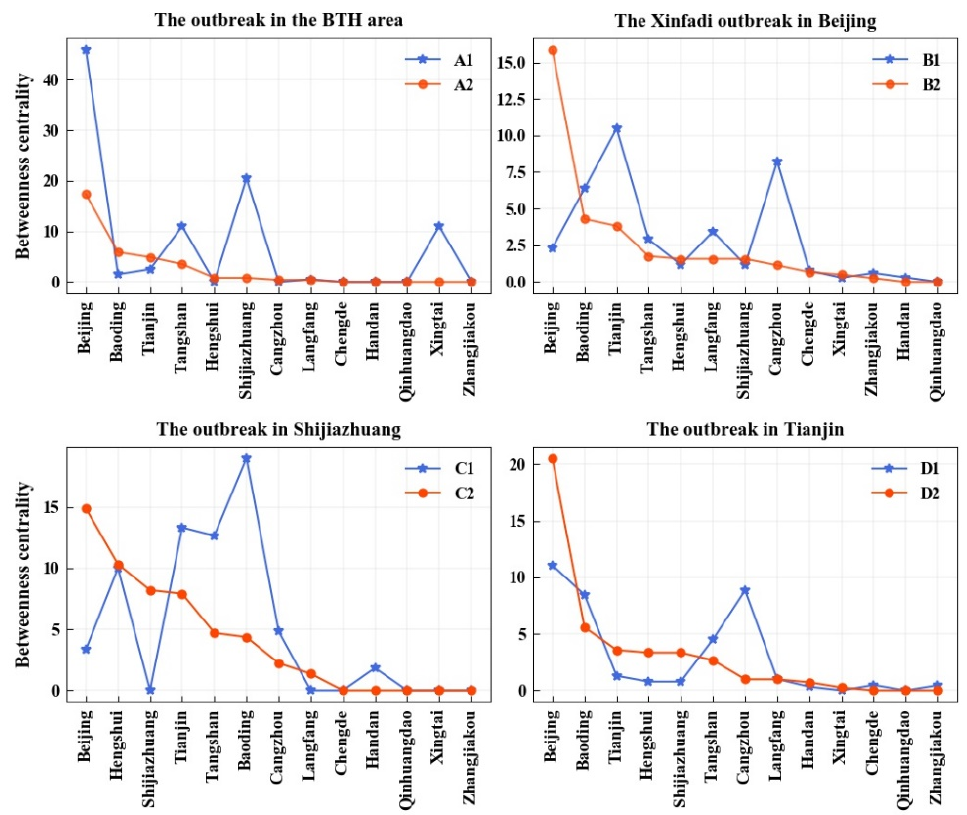
Figure 8. Changes in urban betweenness centrality in the different periods.